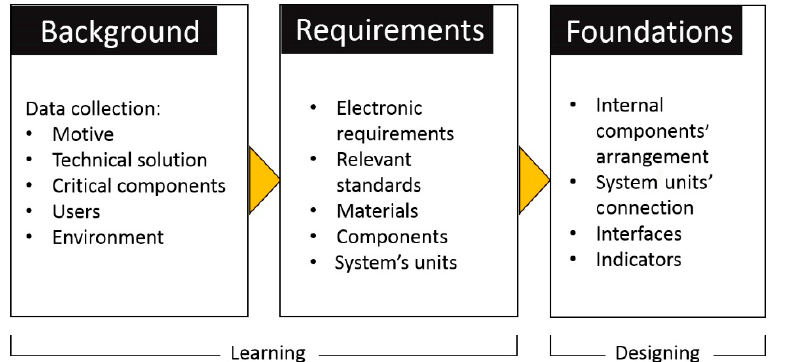
Figure 3. The functionality phase is divided into three